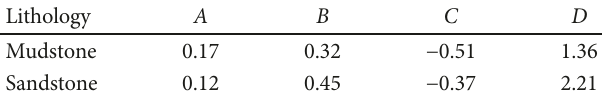
Table 1: Parameter value table for the calculation formula of residual expansion coe ffi cient as mudstone and sandstone rock